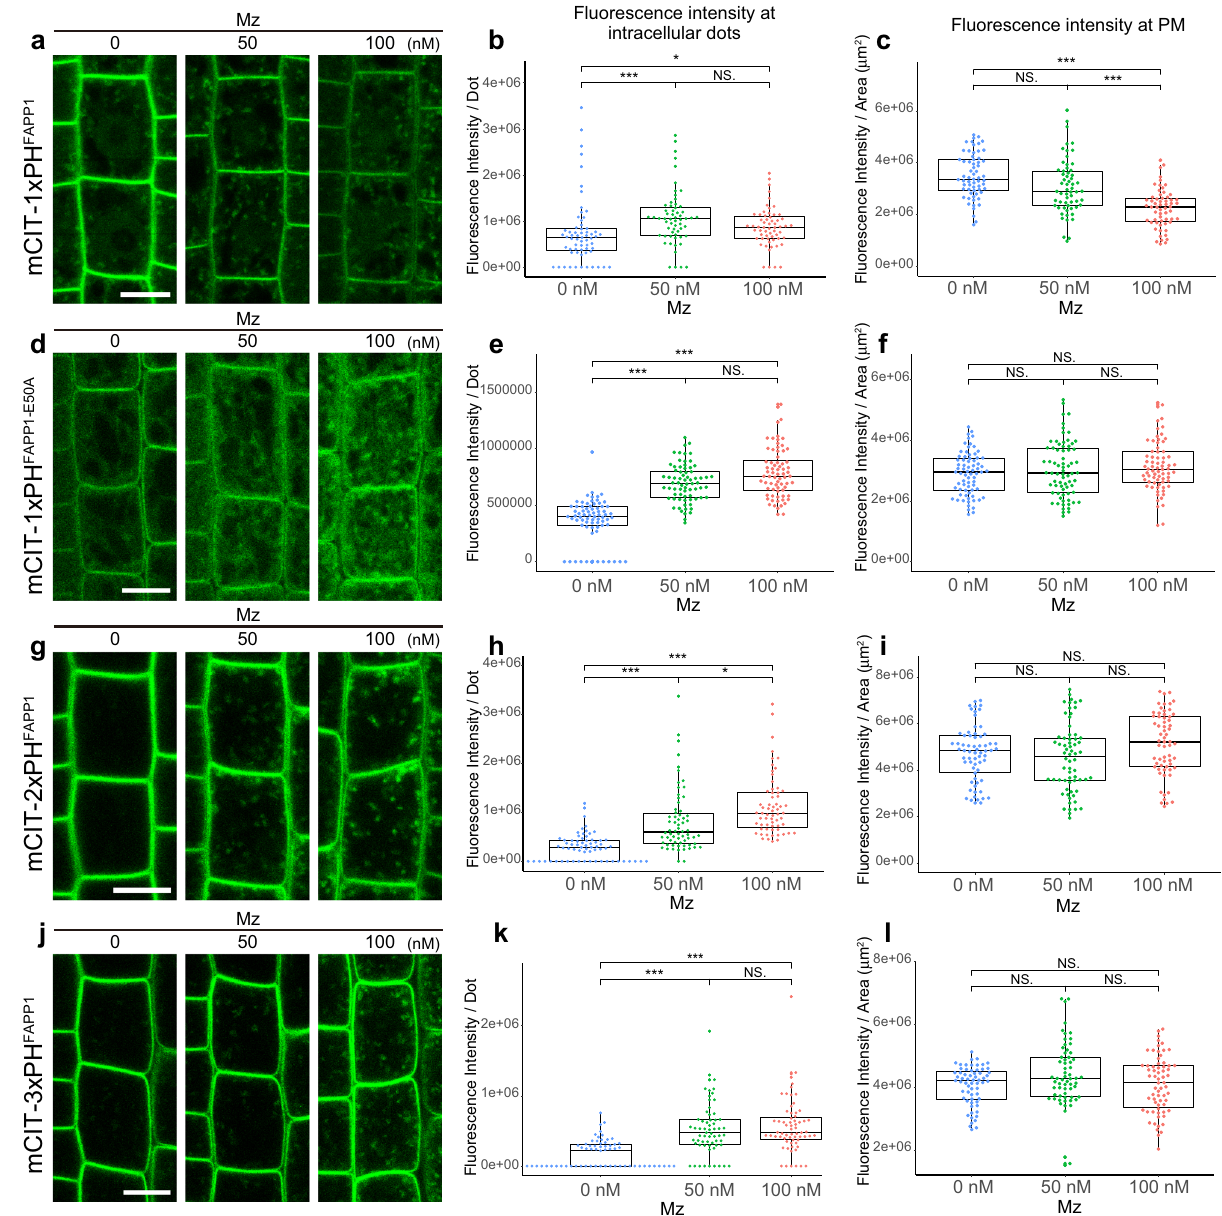
Fig. 2 Very long chain fatty acids are required for the intracellular distribution of PI4P. Confocal micrographs of Arabidopsis root epidermal cells expressing either the PI4P biosensor mCIT-1×PH FAPP1 ( a ), mCIT-1×PH FAPP1-E50A ( d ), mCIT-2×PH FAPP1 ( g ), mCIT-3×PH FAPP1 ( j ) upon 0, 50, or 100 nM Mz (Mz) treatment. Fluorescence intensity at intracellular dots ( b , e , h , k ) and at PM ( c , f , i , l ) was quanti fi ed. All the PI4P biosensors tested showed signi fi cant increase of the signal intensity at intracellular dots upon metazachlor (Mz) treatment while only mCIT-1×PH FAPP1 showed a decrease of the signal at PM ( a – l ). ( b , c ) n = 63 cells from 21 roots (0 nM Mz) and 60 cells from 20 roots (50 and 100 nM). e , f n = 72 cells from 24 roots for each treatment. h , i n = 66 cells from 22 roots (0 and 100 nM), 63 cells from 21 roots (50 nM). k , l n = 63 cells from 21 roots (0 and 100 nM), 66 cells from 22 roots (50 nM). Statistics were done by two-sided Dwass-Steel-Critchlow-Flinger multiple comparison test with Monte Carlo method (10,000 iterations), * P < 0.01, *** P < 0.0001. Each element of the boxplot indicates the following value: center line, median; box limits, the fi rst and third quartiles; whiskers, 1.5× interquartile range; points above or below the whiskers, outliers. Scale bars, 10 µ